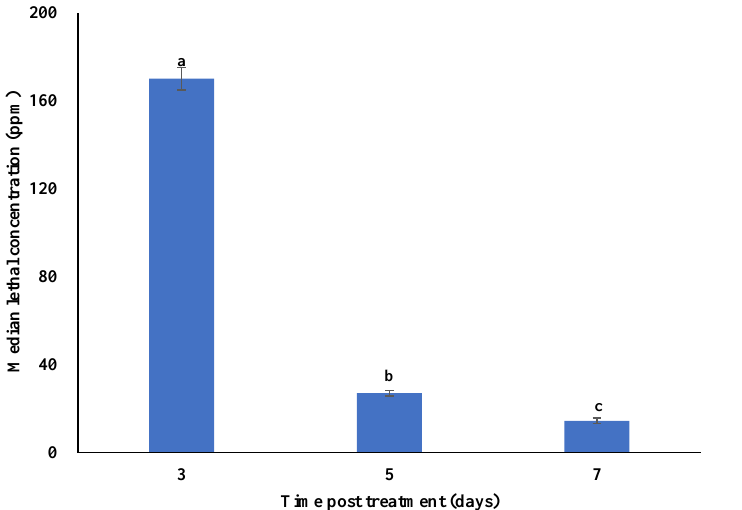
Figure 8. Median lethal concentrations (LC 50 ) of Metarhizium anisopliae – chitosan nanoparticles against P. xylostella under laboratory conditions. Error bars indicate the standard error of the means based on three replicates. Bars with distinct letters at different days post treatment differed significantly from each other.